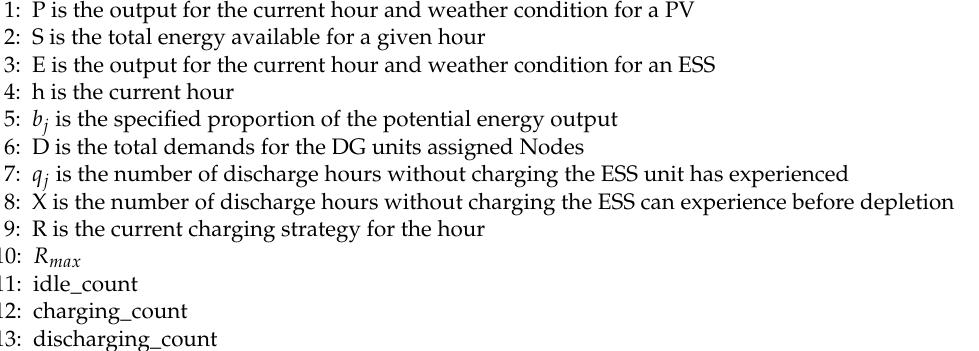
Algorithm 2 Algorithm for adjusting available energy supply each